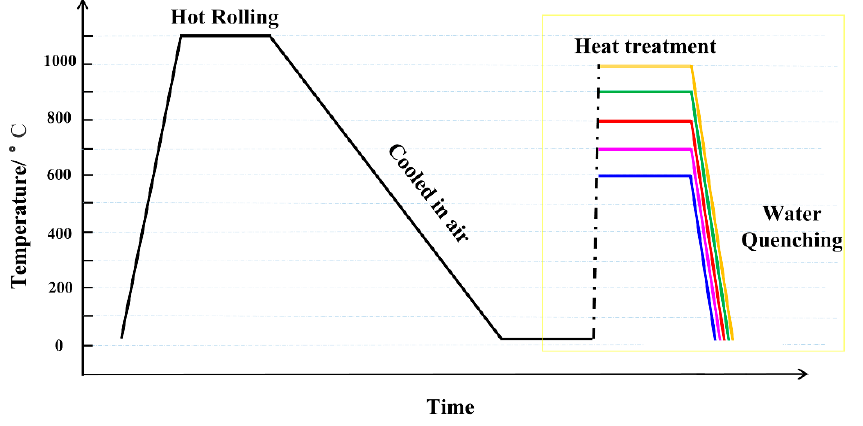
Table 1. The chemical composition of Fe-25Al-5Al (wt%).